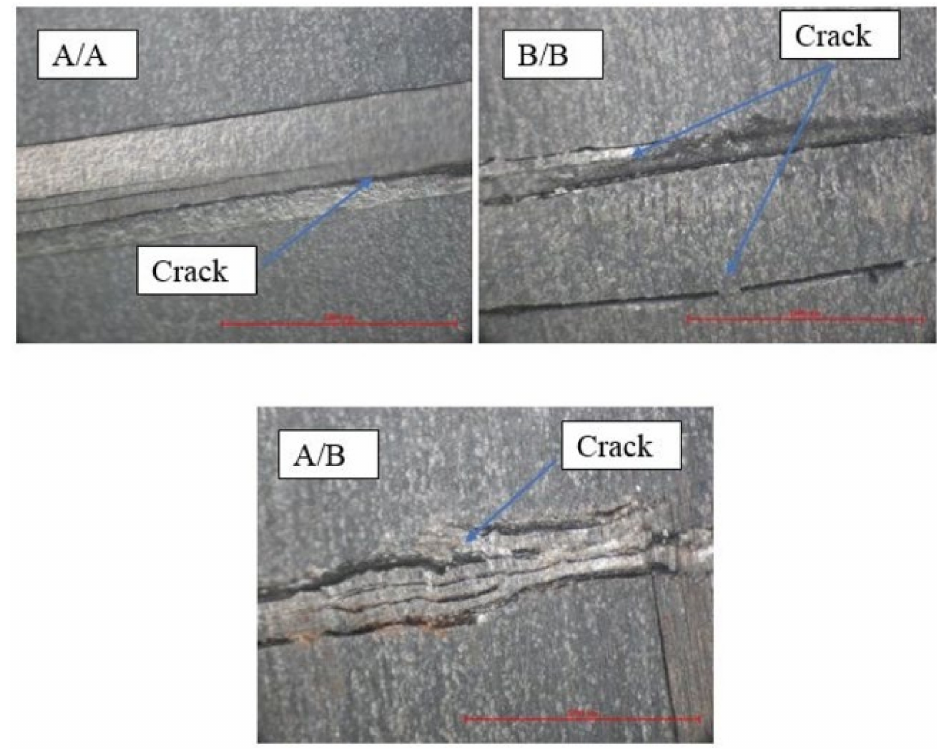
Figure 7. Optical images of failure surfaces (compressive side) of the composite laminates after flexural